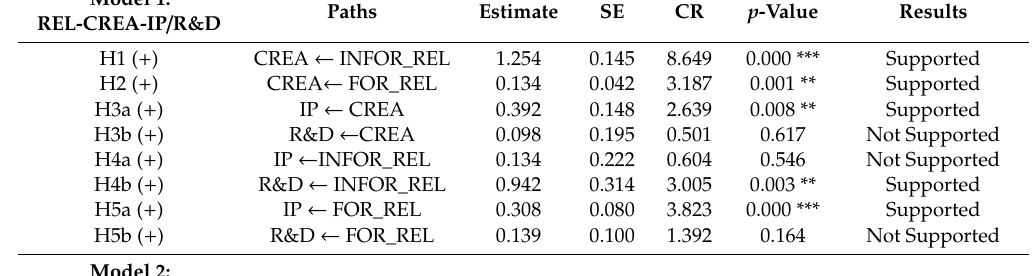
Table 4. Structural model fit, research hypotheses, and results. Model 1: REL-CREA-IP /